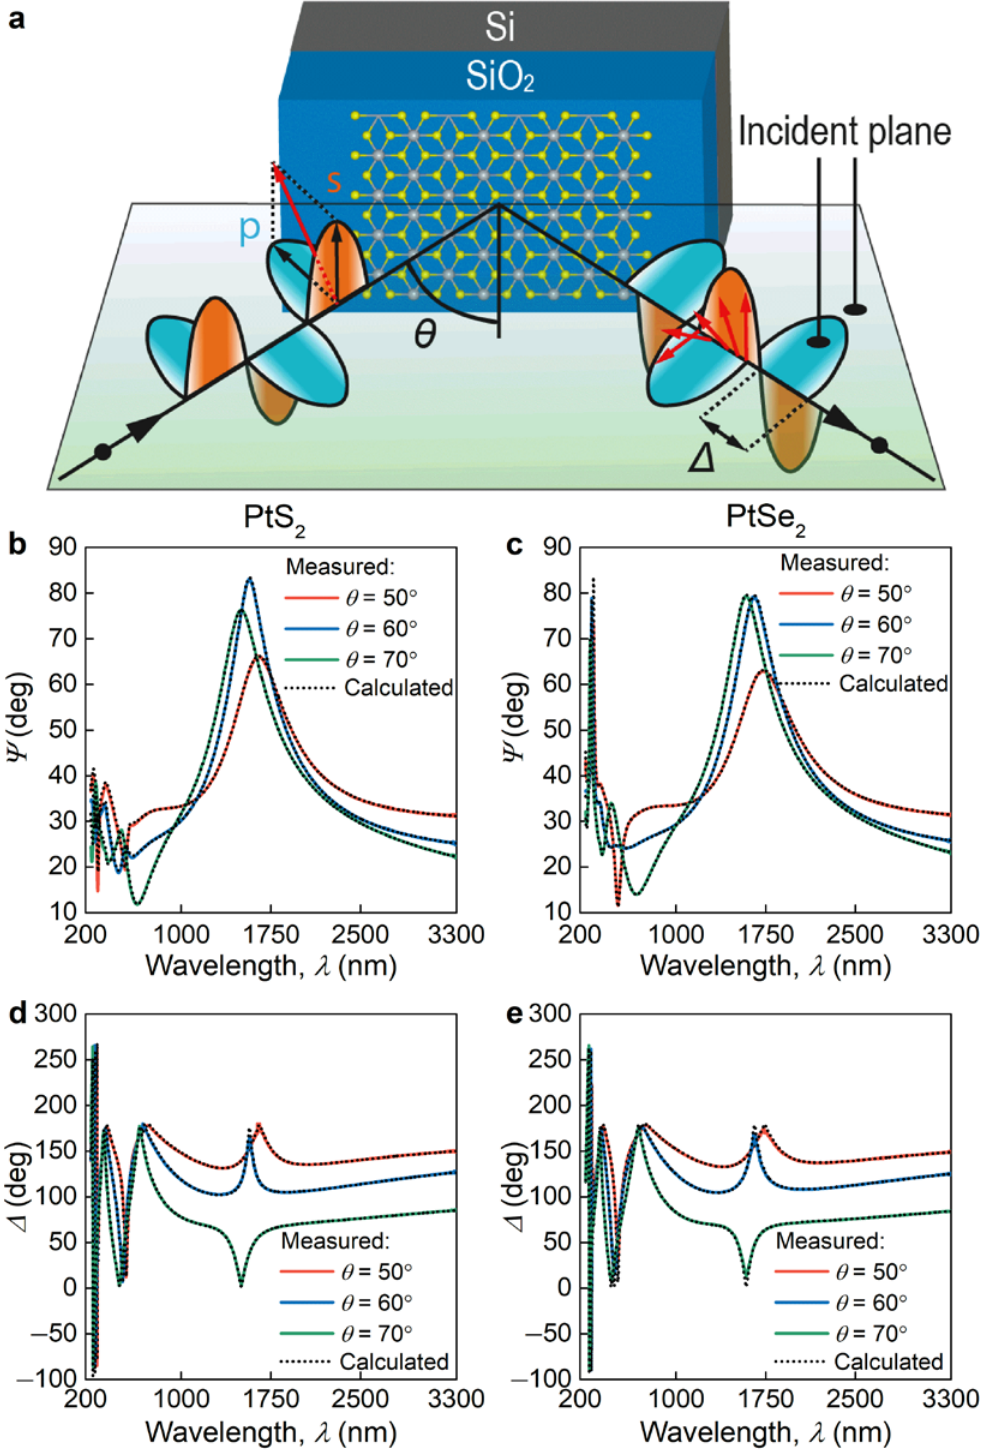
Figure 2. Ellipsometry of PtS 2 and PtSe 2 . ( a ) Schematics of the spectroscopic ellipsometry experimental configuration used to determine PtS 2 and PtSe 2 optical constants. ( b – e ) Plots of the exemplified measured (solid lines) and calculated (dashed lines) ellipsometric spectra of Ψ and ∆ of PtS 2 and PtSe 2 on SiO 2 /Si substrate. For the optical model, we used the thickness determined from AFM (Figure 1c,e), which allowed us to fix the thickness during the fitting procedure. Note that some authors fit the thickness of thin films (<10 nm) and optical constants at the same time.